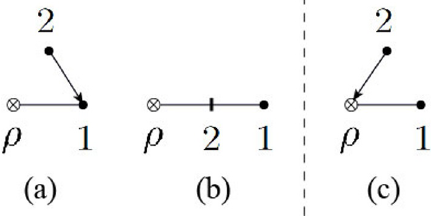
Figure 4 . Type-B graphs with two on-shell